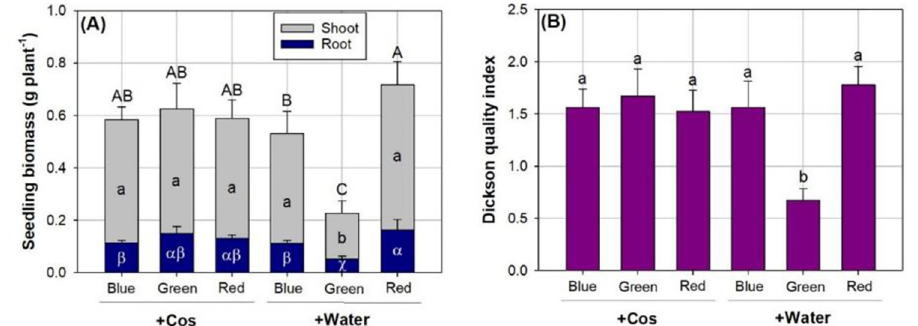
Fig 4. Shoot and root parts’ biomass (A) and Dickson quality index (B) in Podocarpus macrophyllus seedlings exposed to chitosan additive (+Cos) and water (+Water) sprays in three types of light emitting diodes spectra from red, green, and blue lights ( n = 6). Bar height corresponds to the mean of the measurement while the error bars represent standard errors. Different letters represent difference at significant level of 0.05 by Tukey test. In cell A, capital letters label the difference of whole-plant biomass, lower-case-letters label the difference for shoot, and Greek alphabet letters label difference of biomass in root. https://doi.org/10.1371/journal.pone.0267632.g004 biomass in whole plant was greater in seedlings receiving water spray in the red-light spectrum than those receiving water spray in the green and blue light spectra. DQI was found to be lower for seedlings with water spray in green light compared to those subjected to combined red-light and water-spray treatment (Fig 4B). The interaction between green-light spectrum and Cos spray also resulted in a higher DQI than that in combined treatments.